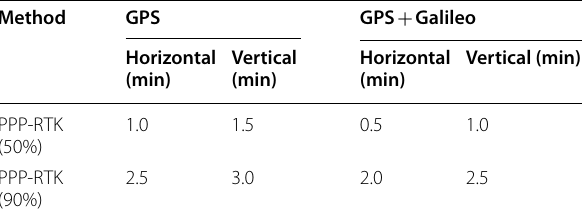
Table 2 Convergence time of PPP-RTK user components for